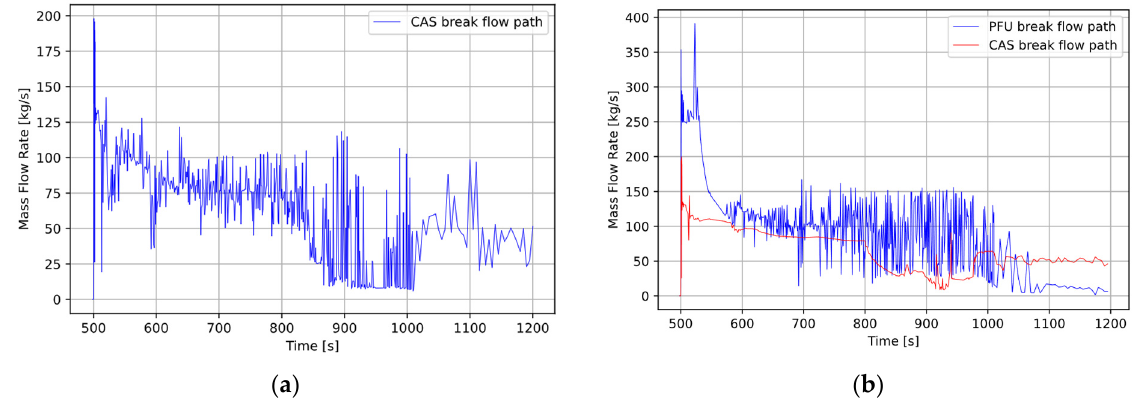
Figure 10. Transient mass flow rate from cassette feeding pipe break in PIE1 ( a ) and PIE2 ( b ) cases.